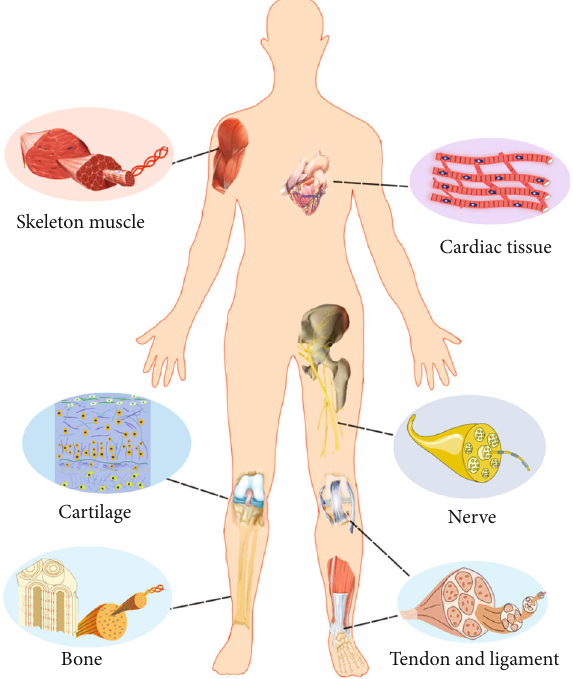
Figure 1: Illustration of typical tissues with fi brous structures whose regeneration can be mediated by 3D